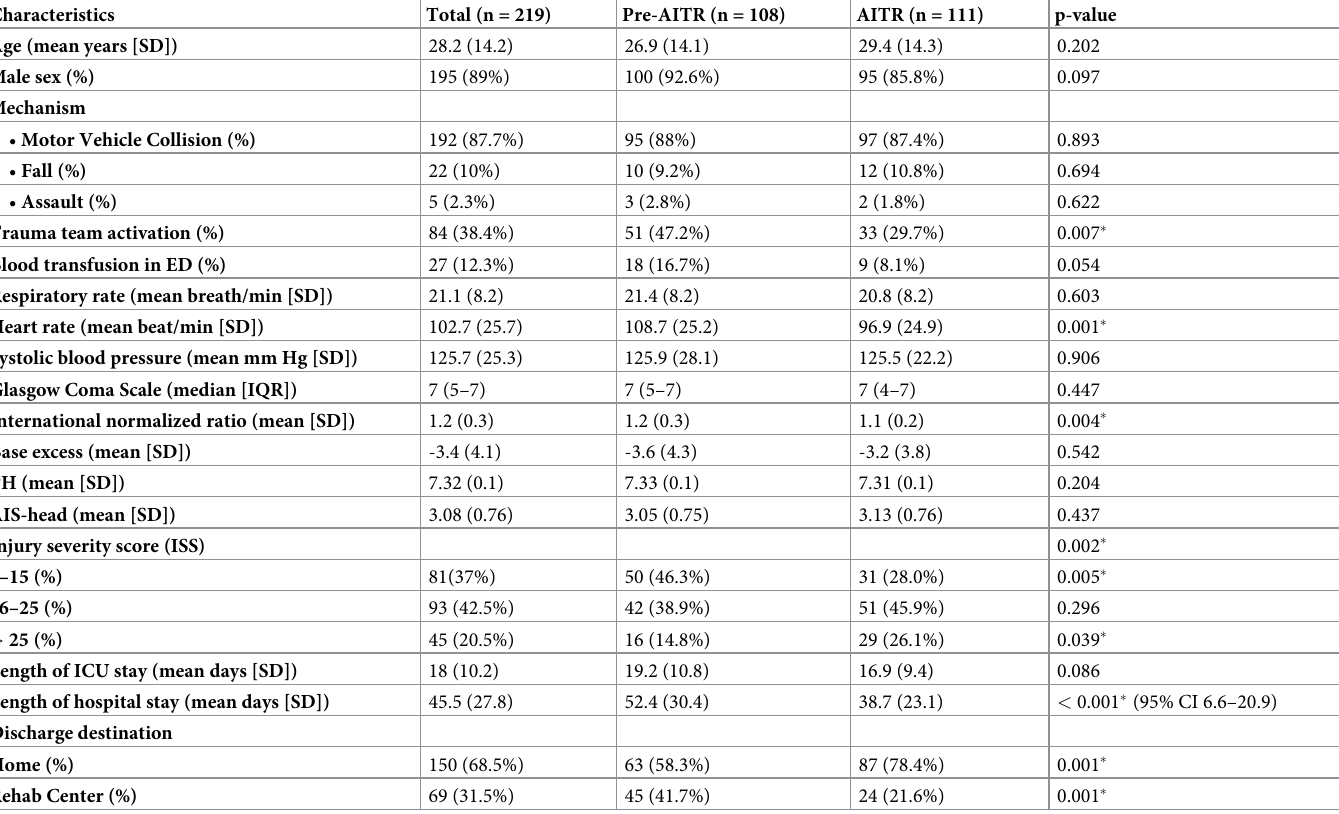
Table 2. Comparison of selected TBI patients’ demographics, mechanisms of injury, baseline (on presentation to ED) characteristics, and outcomes between pre- AITR and AITR.